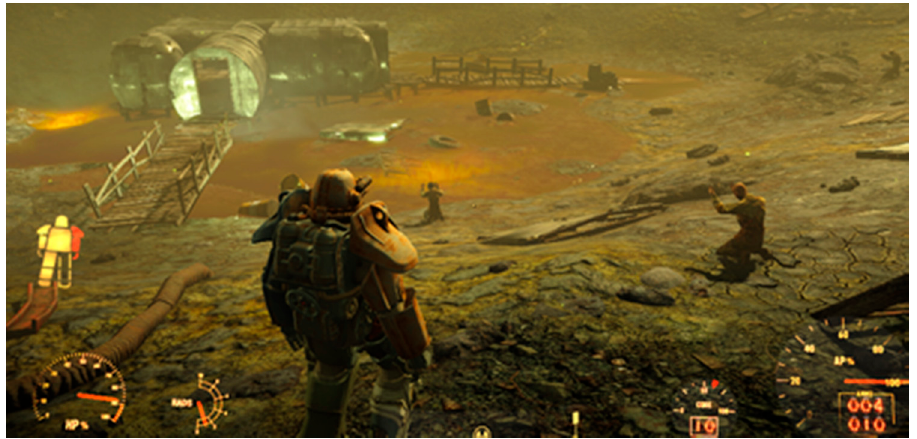
Figure 4. Atom’s place of worship, next to a radiated water crater, in the Glowing Sea.